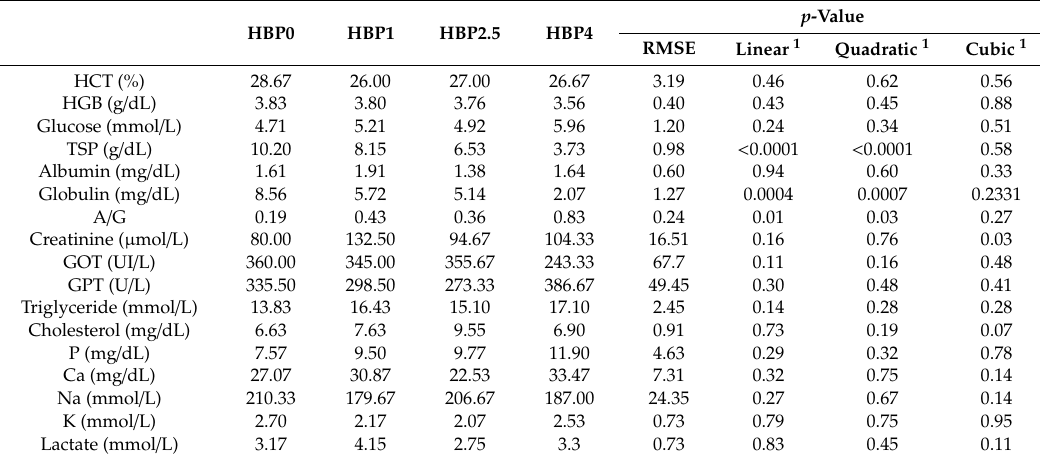
Table 9. Biochemical assessment of blood